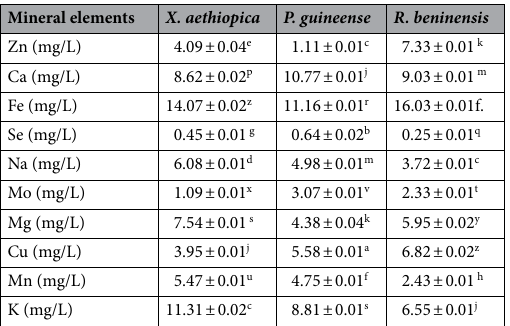
Table 1. Mineral composition of selected spices. Values are expressed as mean ± standard error of mean ( X ± S.E.M.) in triplicate. Values with different letter along the same row are significantly different ( p < 0.05).